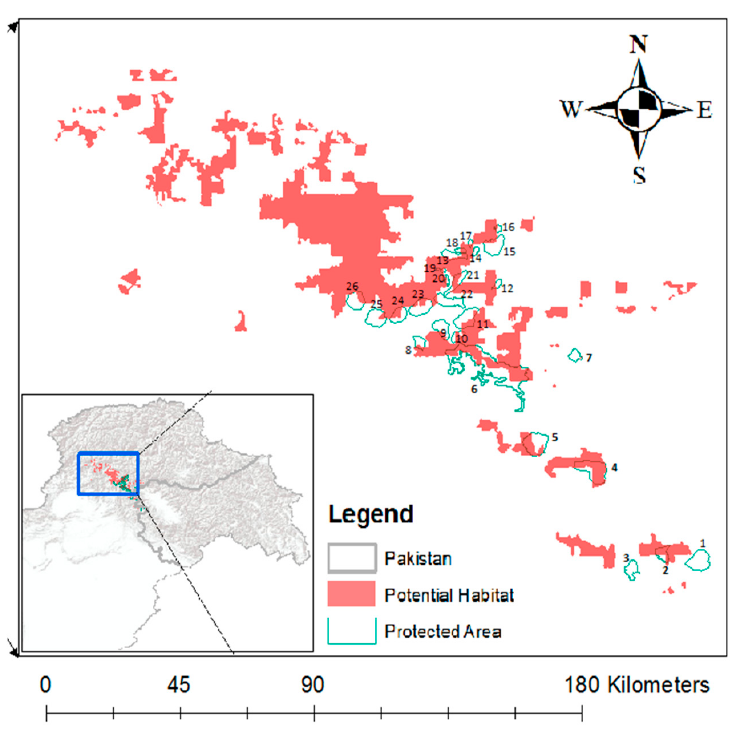
Figure 1. Spatial distribution of protected areas falling within the potential habitat of the species. For names of numbered protected areas see Table 1.